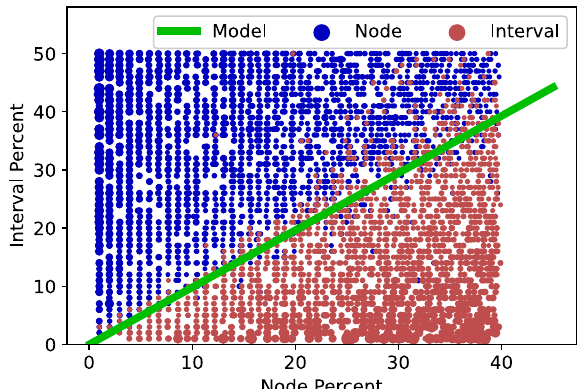
Fig. 8 Node and interval percent for 5,000 compound slices on the Infectious data set. The color of a data point denotes the faster slice, and larger points denote slices where the time difference between node-based and time-based slices is larger. The green line denotes the threshold for our dual linear regression model predictor: it choose a node-based slice for all points above the line and interval-based slice for all points below the